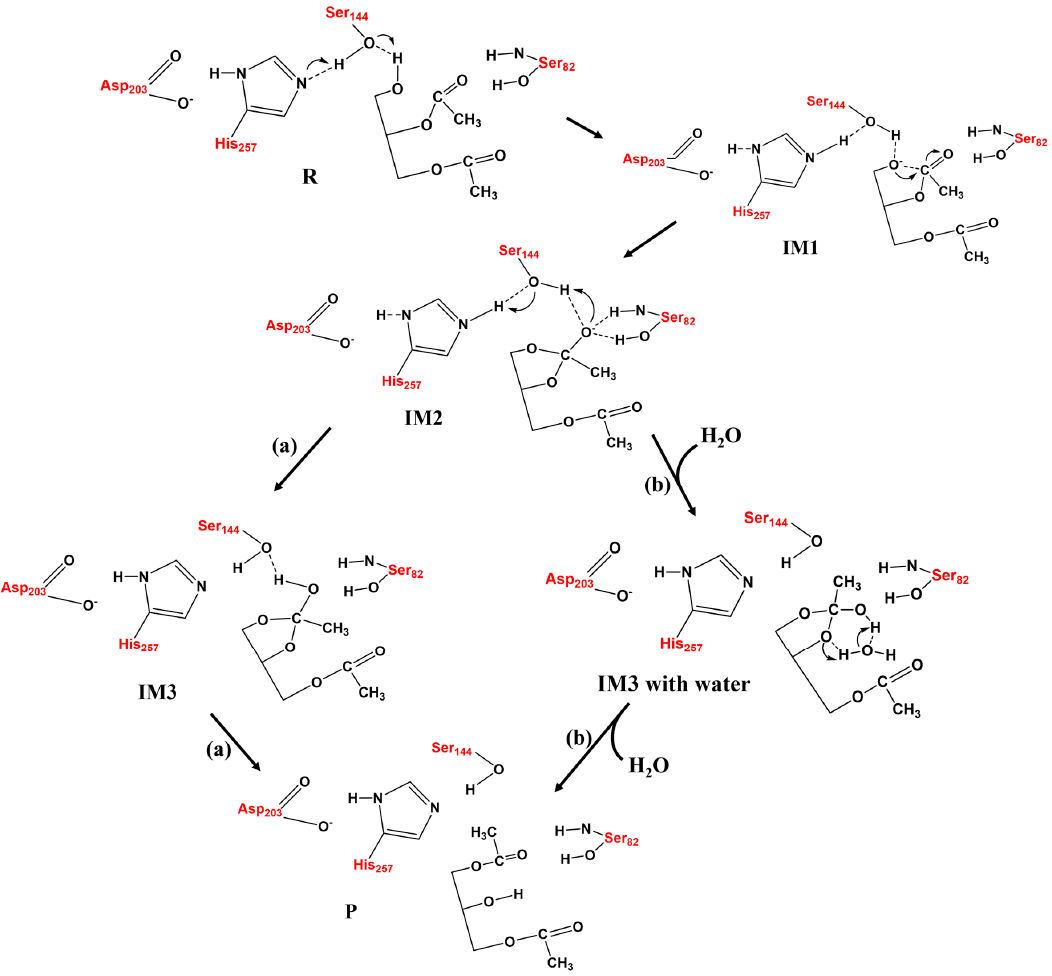
Figure 2. The possible mechanisms of acyl migration (AM) in the lipase-catalyzed mechanism (LCM) scheme: ( a ) without and ( b ) with the aid of water.